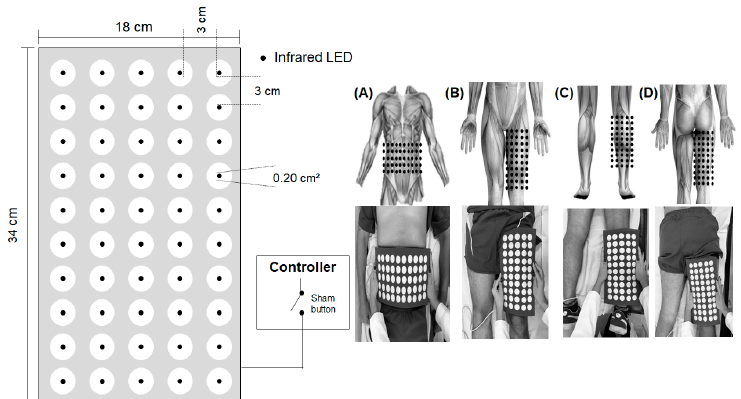
Figure 2. Array of 50 light-emitting diodes (LEDs), with a wavelength of 850 ± 20 nm, power output of 75 mW and a beam area of 0.20 cm 2 in each LED and 3 cm equidistant. For the sham condition, a hidden switch interrupted the light emissions. PBM was performed in direct contact over the skin on rectus and oblique abdomen ( A ), quadriceps femoris ( B ), triceps surae ( C ), and hamstrings ( D ) muscle areas, bilaterally. Table 1. Photobiomodulation parameters and application